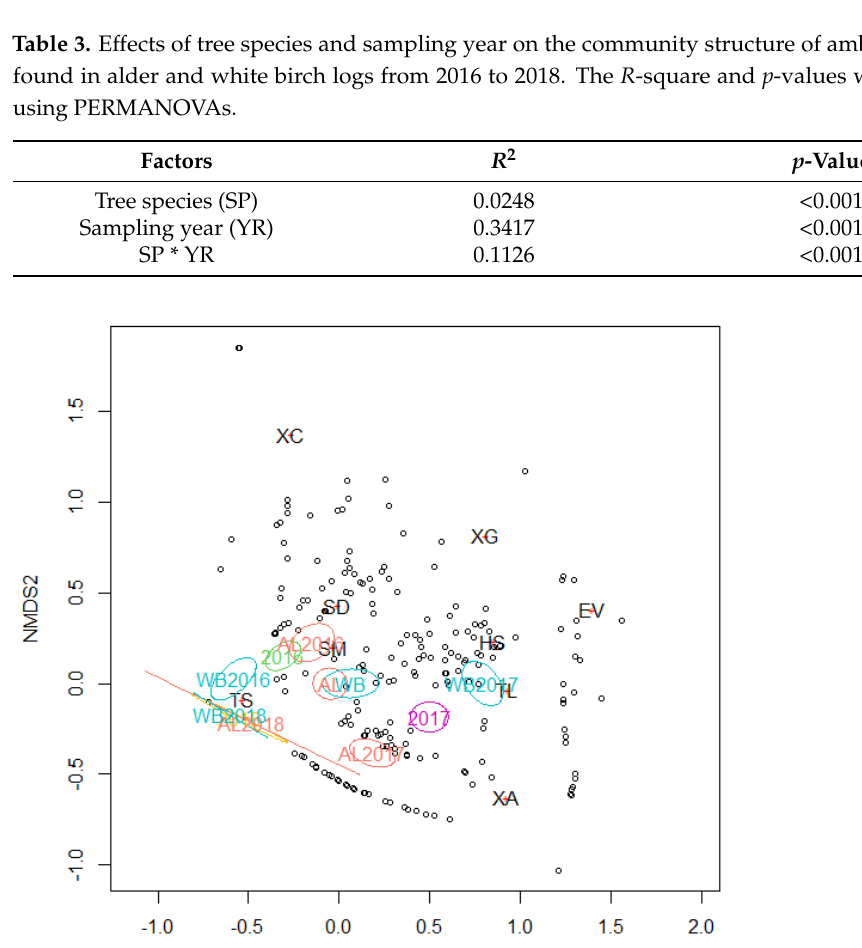
Figure 5. NMDS ordination of ambrosia beetle communities found in alder (AL) and white birch (WB) logs over three years. The ovals indicate a 95% confidence range of the regimes in each tree species, each year, or each of their combinations. Open circles (o) and red crosses (+) indicate the billet samples and beetle species, respectively. The NMDS is based on Chao’s distance matrix. Logs without beetles were excluded from this analysis, as they are not relevant to Chao’s distance. See Table 1 for abbreviations of insect species.